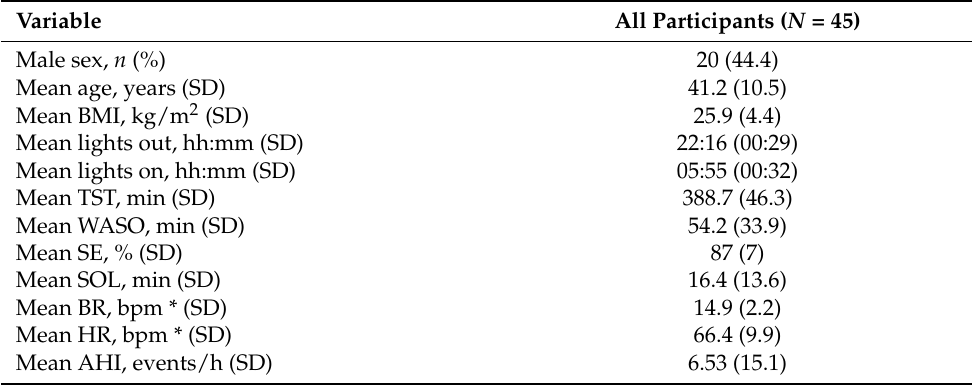
Table 1. Demographics of the study cohort and PSG-derived summary measures.